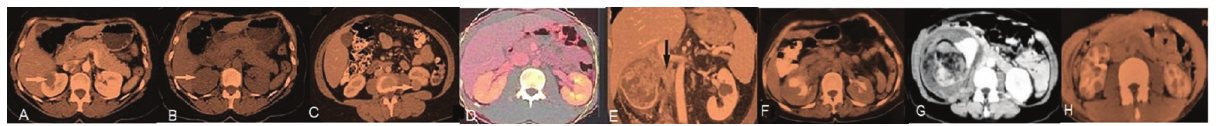
Figure 7 - Contrast-enhanced computed tomography of the kidney. A: Clear cell renal carcinoma. B: Papillary renal cell carcinoma-type I. C: Papillary renal cell carcinoma-type II. D: Chromophobe renal cell carcinoma. E: Collecting duct renal cell carcinoma. F: Infiltrative